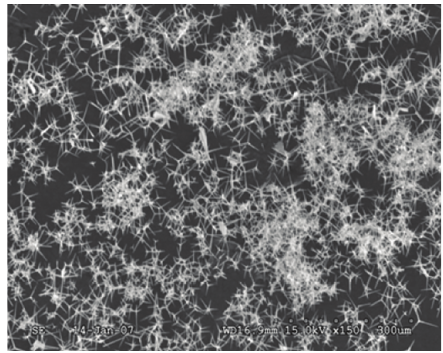
Figure 1: SEM image of the ZnO